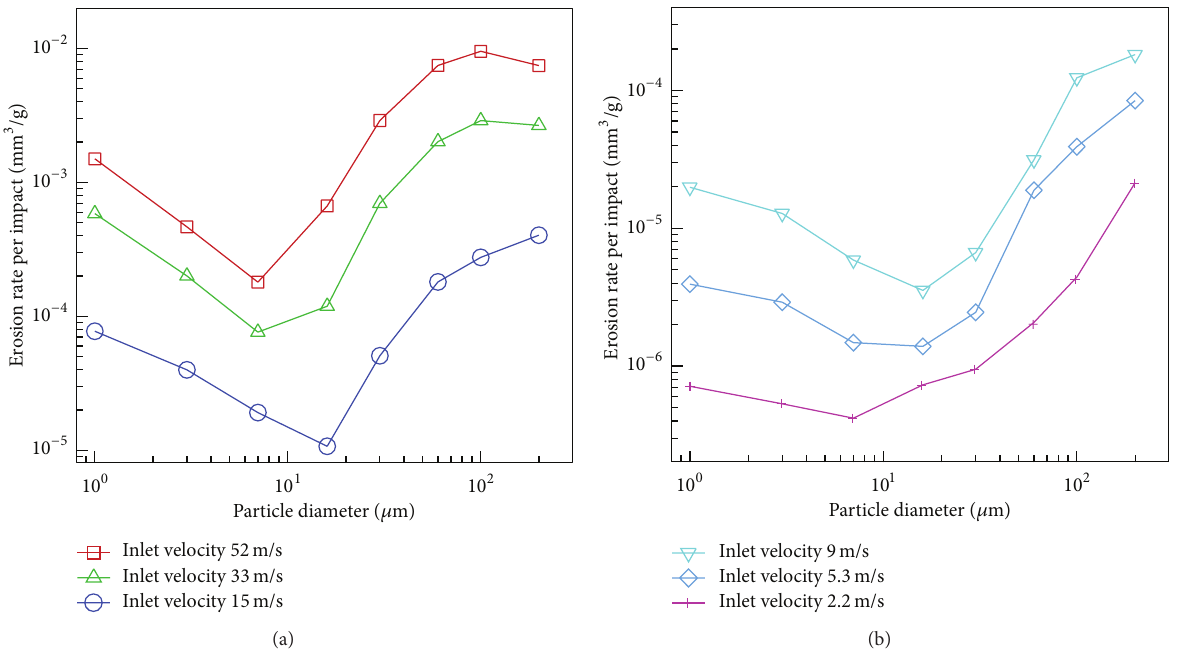
Figure 2: Comparison of the erosion rate 𝐸 V per impact particle against the particle diameter and inlet flow velocity: (a) larger inlet velocities of 15, 33 , and 52 m/s and (b) smaller inlet velocities of 2.2, 5.3, and 9 m/s.